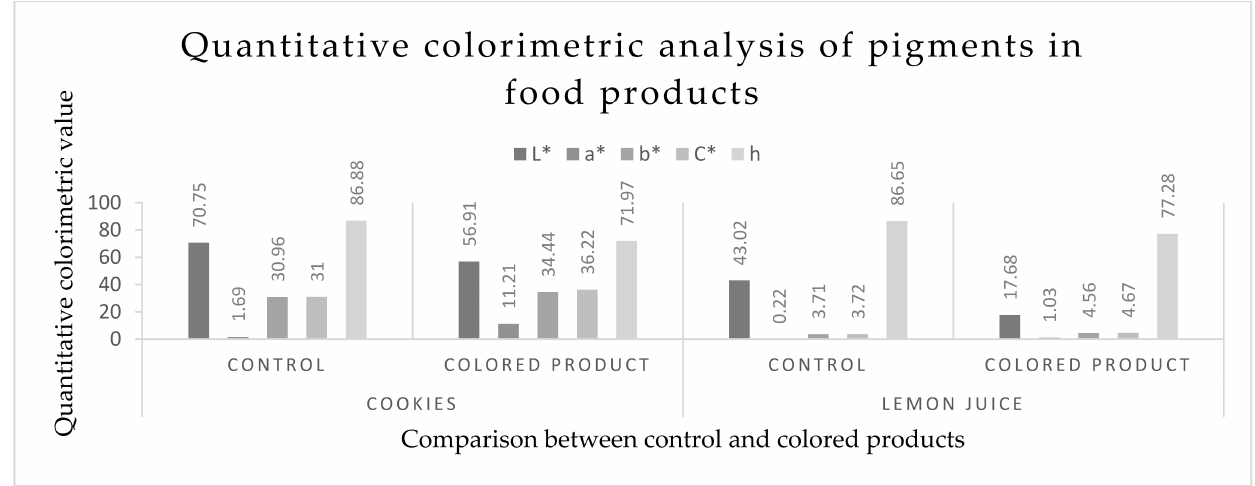
Figure 10. Comparison of L*, a*, b*, C*, and h between colored and colorless cookies and lemon juice, where, L*—lightness, read from 0 (black) to 100 (white); a*—(positive) red color, (negative) green color; b*—(positive) yellow color, (negative) blue color; C*—purity of the color;